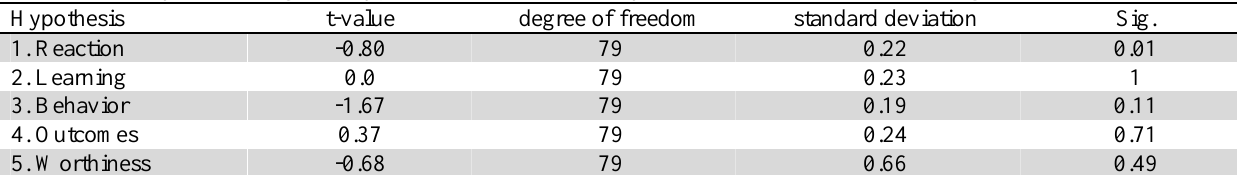
t-value degree of freedom standard deviation